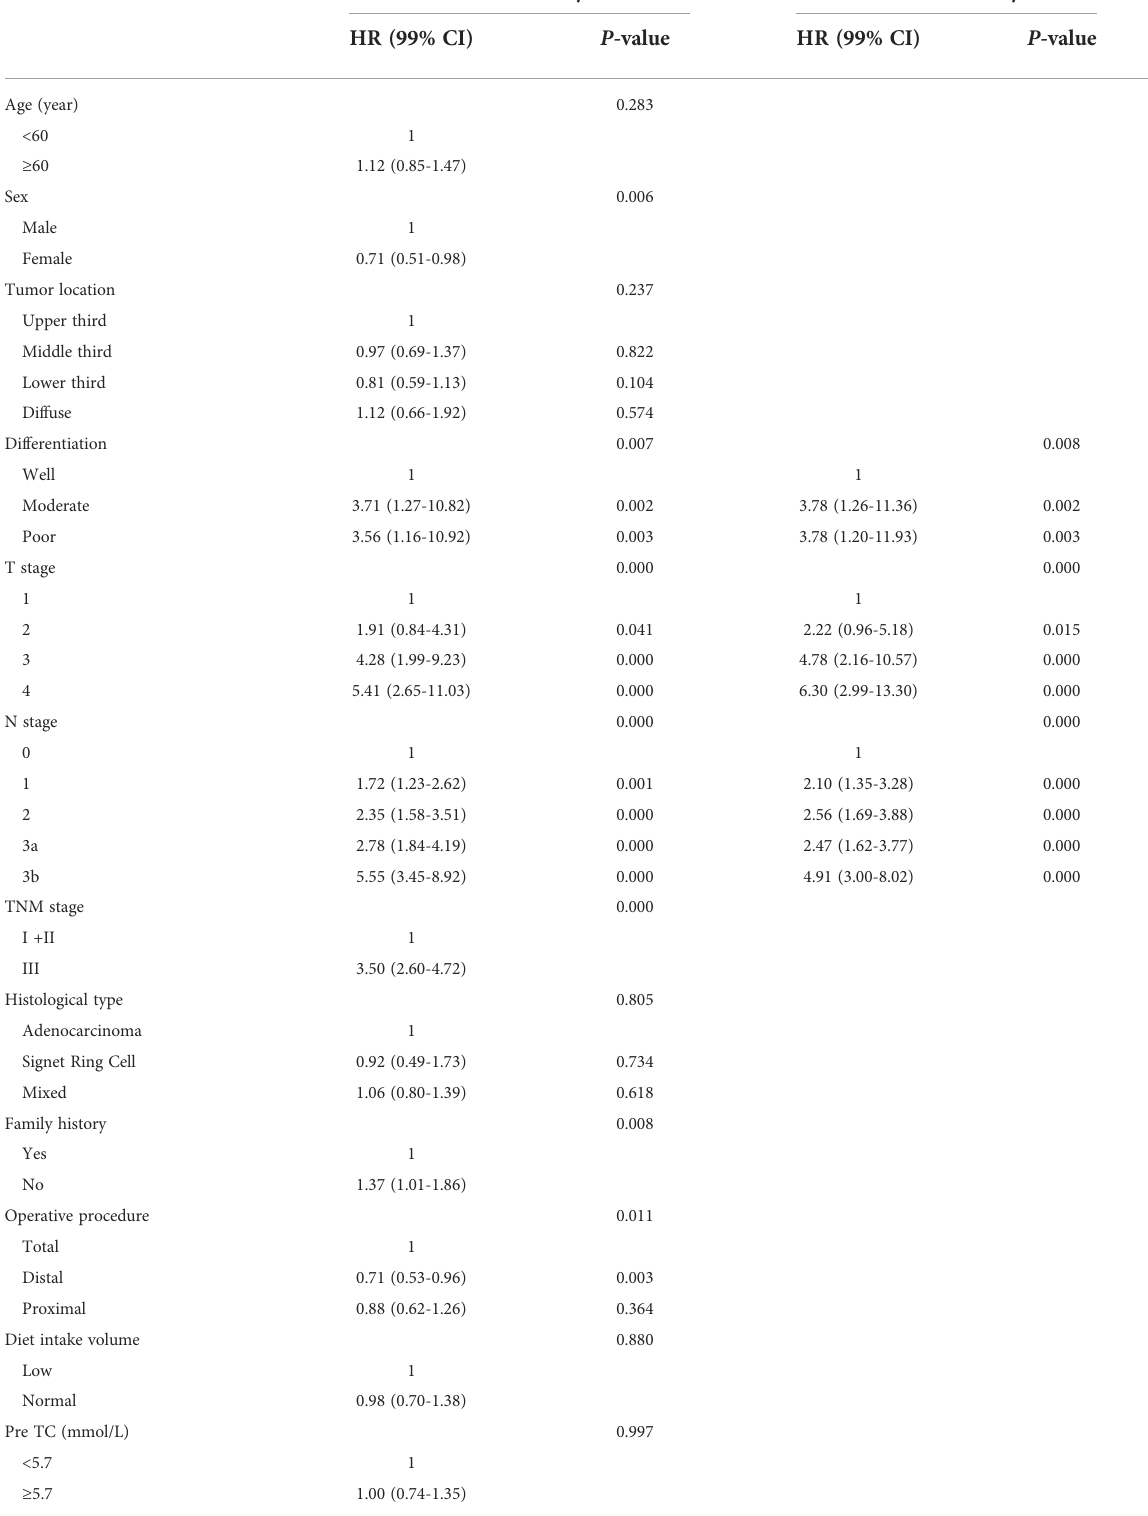
TABLE 3 Univariate and multivariate cox proportional hazard model of gastric cancer with